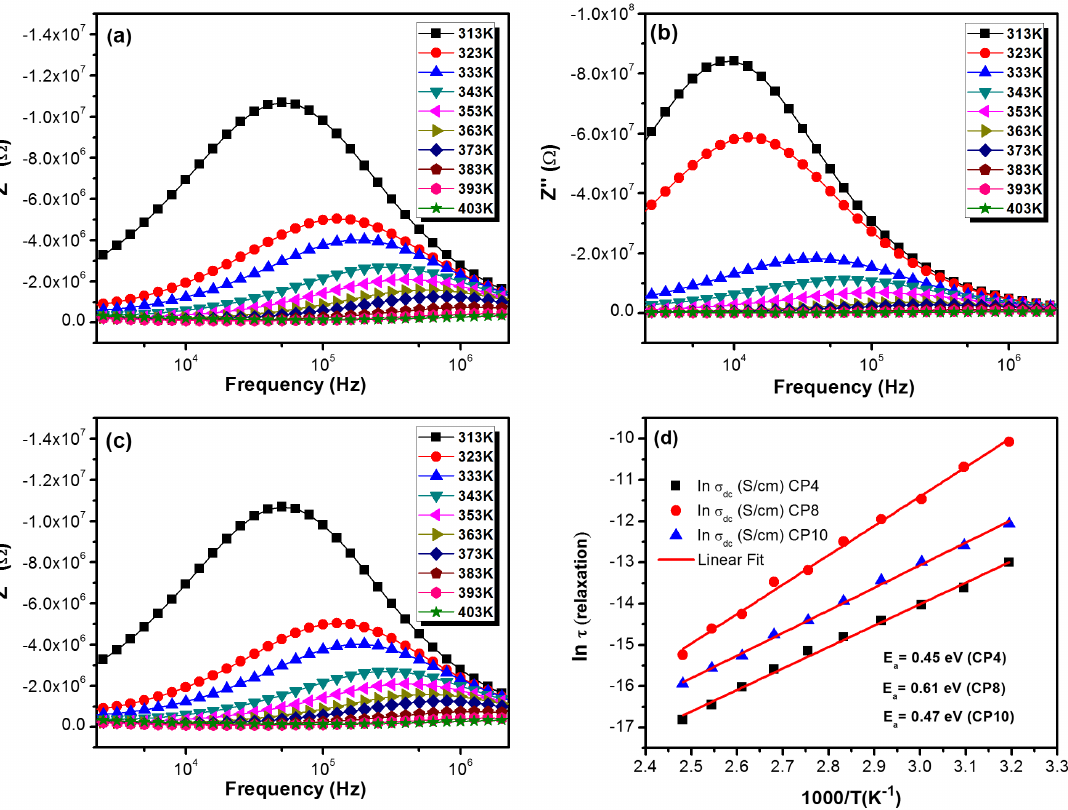
Figure 2. Variation of Z” with frequency at different temperatures of synthesized blends (a) CP4 (b) CP8 (c) CP10 and (d) Variation of relaxation time of charge carriers versus 1000/T of synthesized blends at various